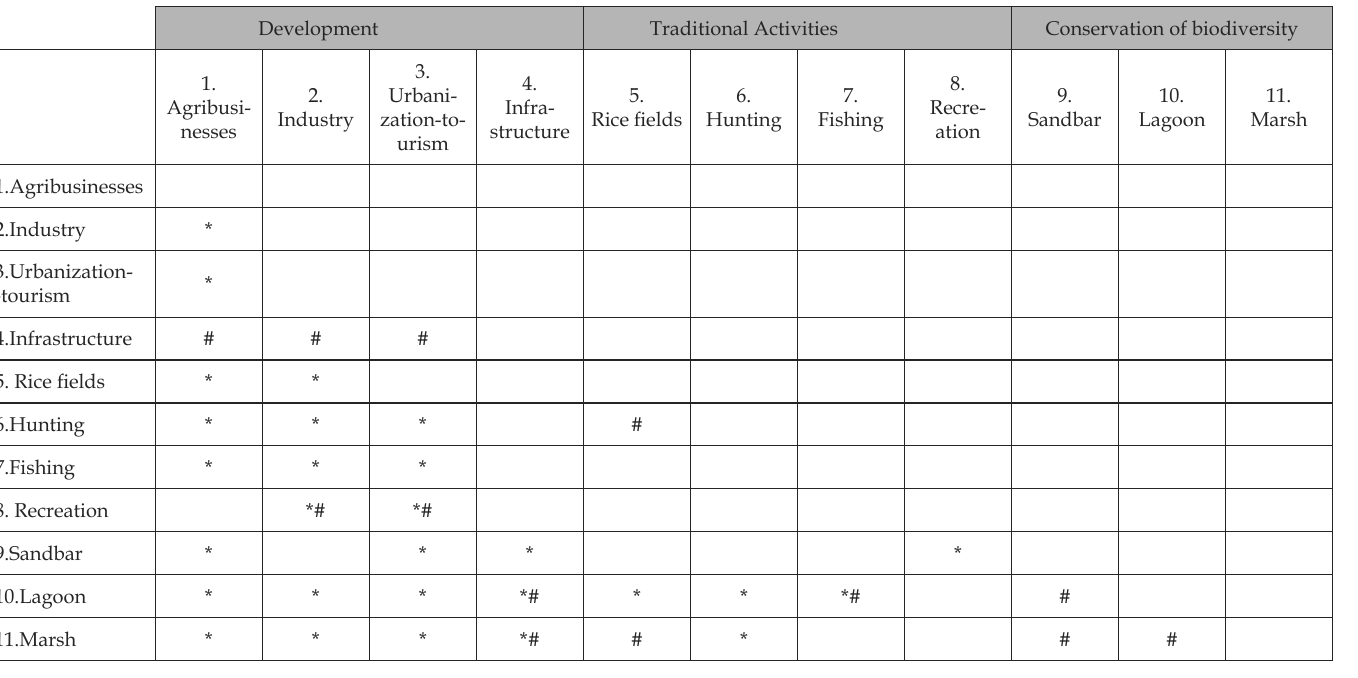
48 Table 1. Nodes of con (cid:223) ict and cooperation between development, traditional activities and conservation of environment.